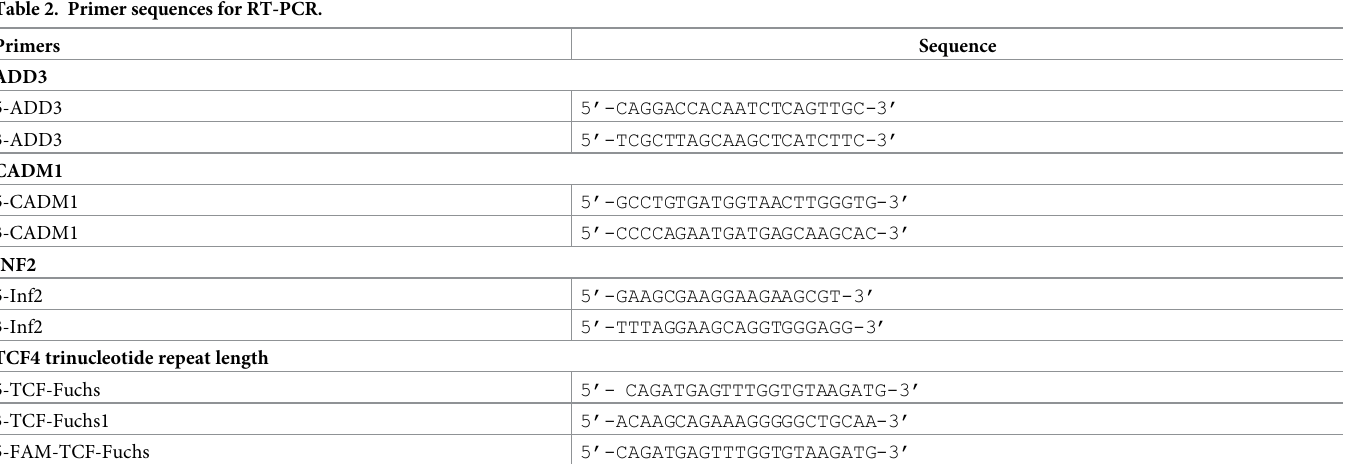
Table 2. Primer sequences for